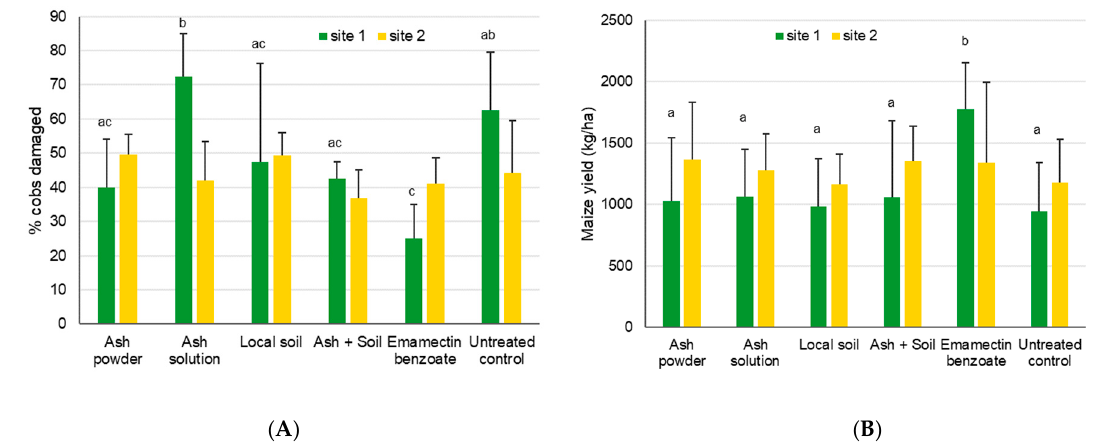
Figure 9. Mean maize cob damage induced by FAW + SD ( A ) and mean maize yields ( B ) after treatment with ash- or soil-based products for site 1 near Wa, Upper West, Ghana, and site 2 near Accra, Ghana. Bars sharing the same letters are not significantly different from each other, while missing letters indicate that no significant differences were found (i.e., for site 2).